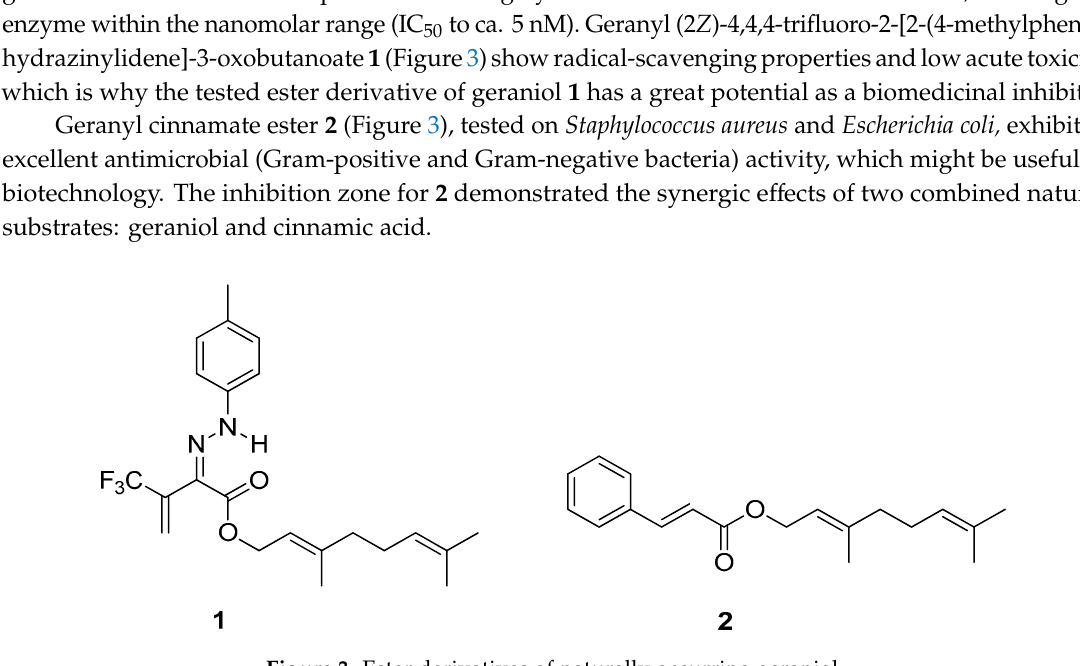
Figure 4. Geraniol-based phenols/methoxyphenols. Cis - and trans -geraniol as raw material was used for the synthesis of four isomers of 6,7- dihydroxy-3,7-dimethyloct-2-enoic acid 9–12 (Figure 5) to obtain monoterpene derivatives with antifungal activity. The in vivo bioassay results showed that chiral acid ( Z , S )— 10 demonstrated promising results as an antifungal agent. The tests confirmed 80–100% inhibitory rates of ( Z , S )-6,7- dihydroxy-3,7-dimethyloct-2-enoic acid against Pseudoperonospora cubensis , Erysiphe graminis , Puccinia sorghi, and Colletotrichum gloeosporioides at a concentration of 400 µM.